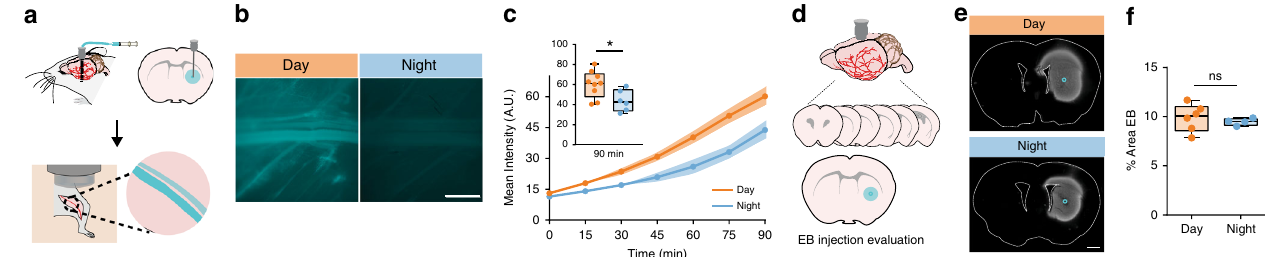
Fig. 2 Interstitial fl uid clearance is higher during the day. a Schematic of experiment. b Representative Cy5 images of the femoral vein from animals 90 min after evans blue (EB) injection during the day (orange) or night (blue). White scale bar: 1 mm. c Mean pixel intensity in arbitrary units (A.U.) over 90 min post EB injection. Thick lines indicate group means with SEM shaded, individual points indicate time image was taken. The inset is a boxplot of the magnitude of fl uorescence at 90 min, two-sided t test, p = 0.0256. Time 0 is tracer infusion start. Day: n = 9 mice, night: n = 6 mice. Asterisk indicates p < 0.05. d Schematic of processing brains to check injection localization and speci fi city. e Representative striatal EB injection sites. Blue circle indicates probe end. White scale bar: 1 mm. f Boxplot of percent area of EB quanti fi ed in a subset of brains during the day ( n = 6 mice) and night ( n = 4 mice). All boxplots: minima is minimum value, maxima is maximum value, center is median and quartiles shown by box and whiskers, with individual animals shown as colored dots, ns: not signi fi cant. Source data are provided as a Source Data fi